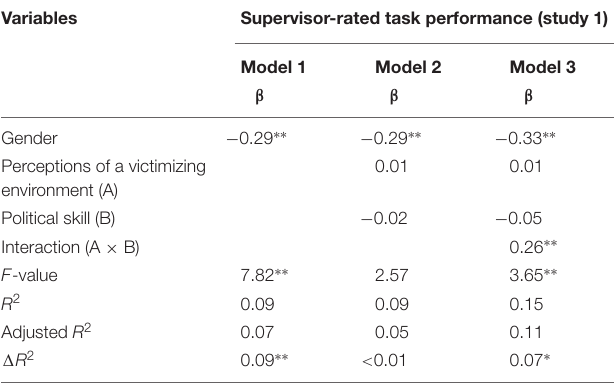
TABLE 2 | Multiple regression results for task performance in Study